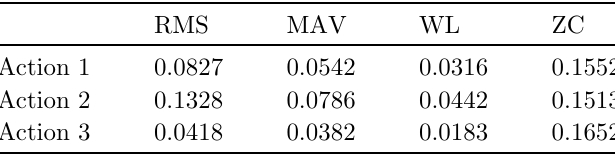
Table 1. Feature